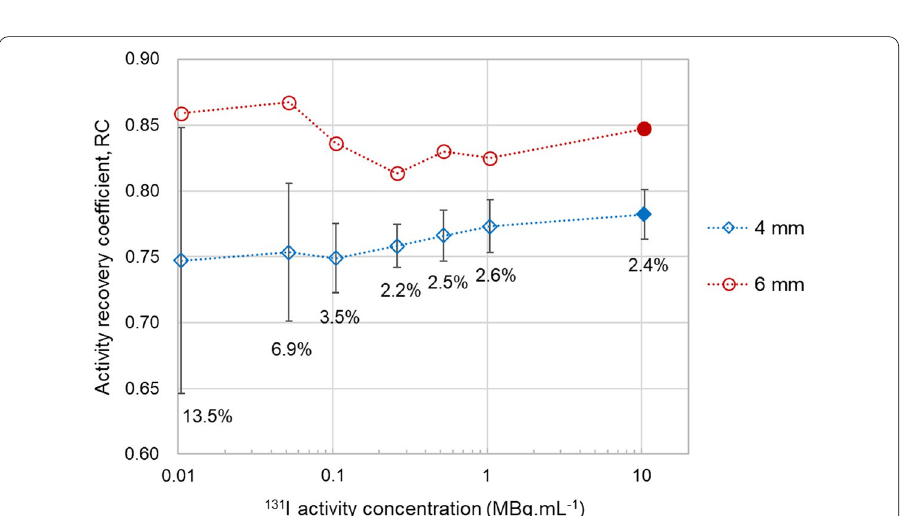
Fig. 4 RC for the 4-mm and the 6-mm rods for various 131 I activity concentrations of the phantom scan. Empty symbols indicate RC values obtained from reconstructions emulating activity concentrations lower than the activity concentration actually imaged (10.4 MBq mL − 1 , RC values indicated by filled symbols). Error bars and labels (shown only for the 4-mm rod) indicate the expanded statistical uncertainty of activity ± recovery, U Rec , at the 95.5%